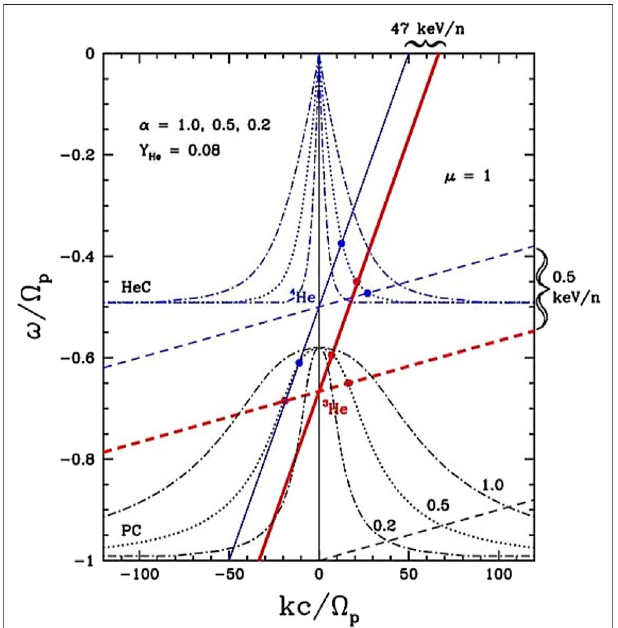
FIGURE 7 | Selective acceleration of 3 He in impulsive solar fl ares (Liu et al.,